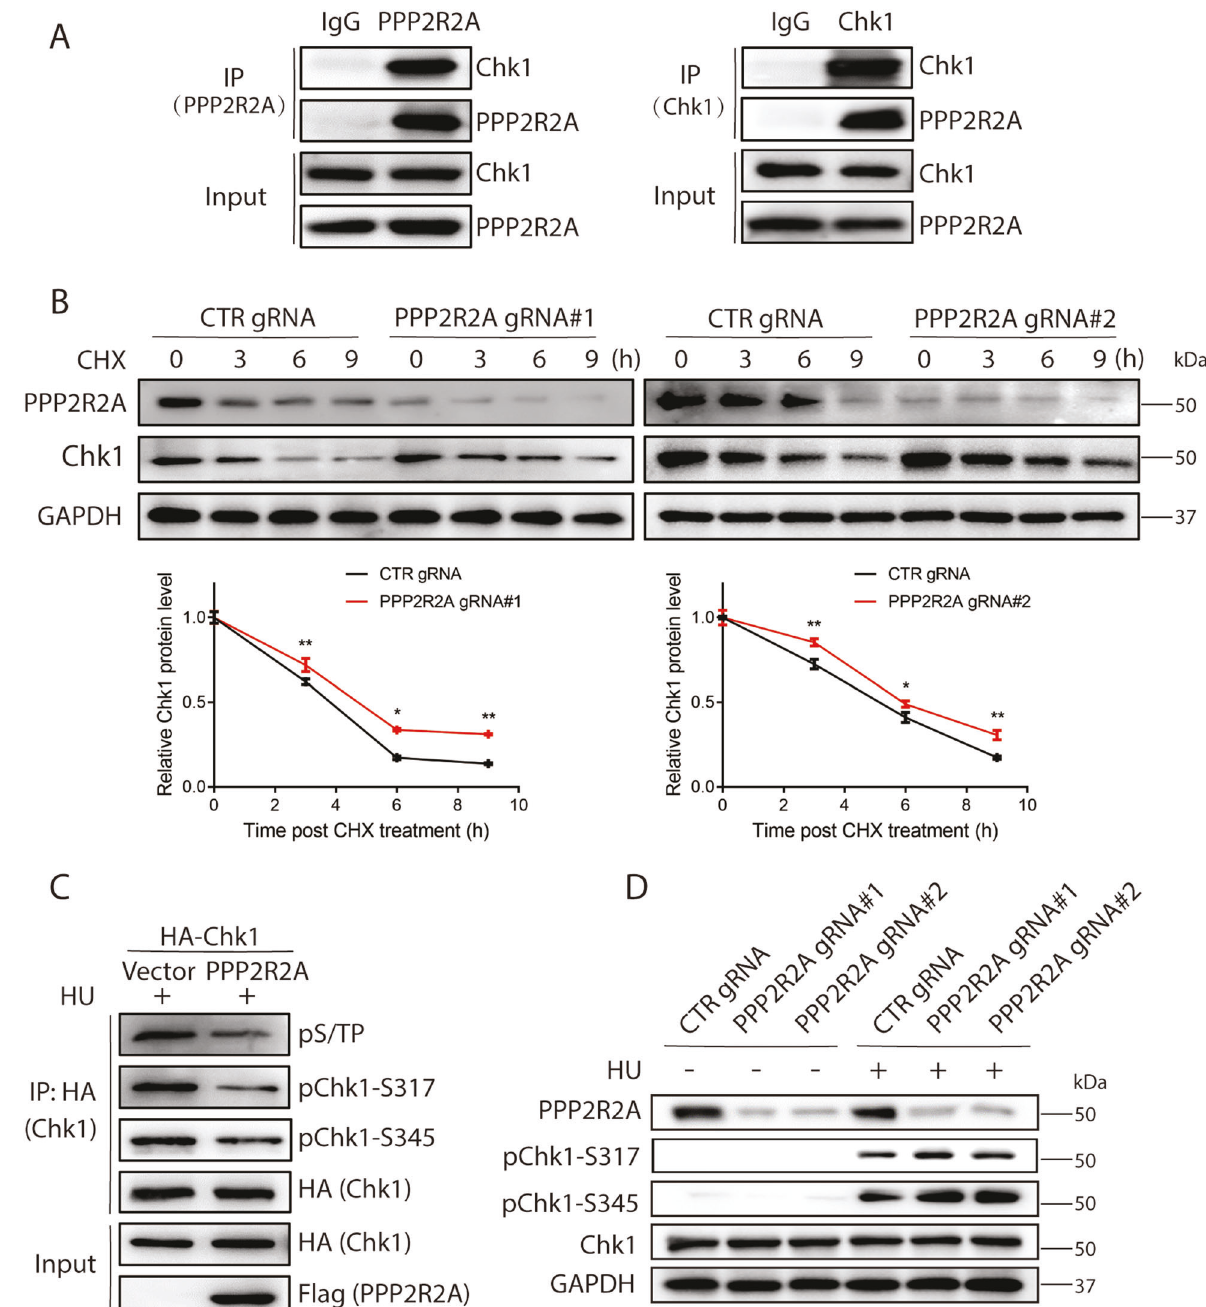
Fig. 5 PPP2R2A promotes the dephosphorylation of Chk1 at Ser317 and Ser345 under HU treatment. A Reciprocal co- immunoprecipitation analysis between PPP2R2A and Chk1. MCF-7 cells were lysed and processed for co-immunoprecipitation and Western blotting experimentations using the indicated antibodies. B PPP2R2A de fi ciency stabilizes Chk1 protein level. MCF-7 cells with or without PPP2R2A knockout with two independent gRNAs were treated with cycloheximide (50 μ g/ml) and were subjected to Western blotting analysis at the indicated time points. The protein expression of Chk1 was quanti fi ed from three independent experiments. * P < 0.05, ** P < 0.01. C 293T cells transiently co-transfected with Flag-PPP2R2A and HA-Chk1 were lysed and immunoprecipitated by anti-HA antibody under denaturing condition. Western blotting analysis was performed using the indicated antibodies. D MCF-7 cells transduced with two independent PPP2R2A-targeting gRNAs were treated with 2 mM HU for 18 h. Whole-cell lysates were subjected to Western blotting and probed with indicated antibodies. GAPDH was used as loading varied signi fi cantly among tumor stage of breast cancer but not patients with breast cancer. Our analysis found that patients with the PPP2R2A group (Fig. 8K, L). Taken together, these data reveal a decreased expression of PPP2R2A and increased expression of negative correlation between PPP2R2A and pChk1-S317, high- Chk1 had signi fi cantly worse survival (Figs. 8I, J, P < 0.05). We next lighting the clinical relevance of PPP2R2A – Chk1 signaling axis in analyzed the expression of PPP2R2A and Chk1 with tumor stage of the progress of patients with breast cancer. breast cancer using GEPIA database, and found that Chk1 group